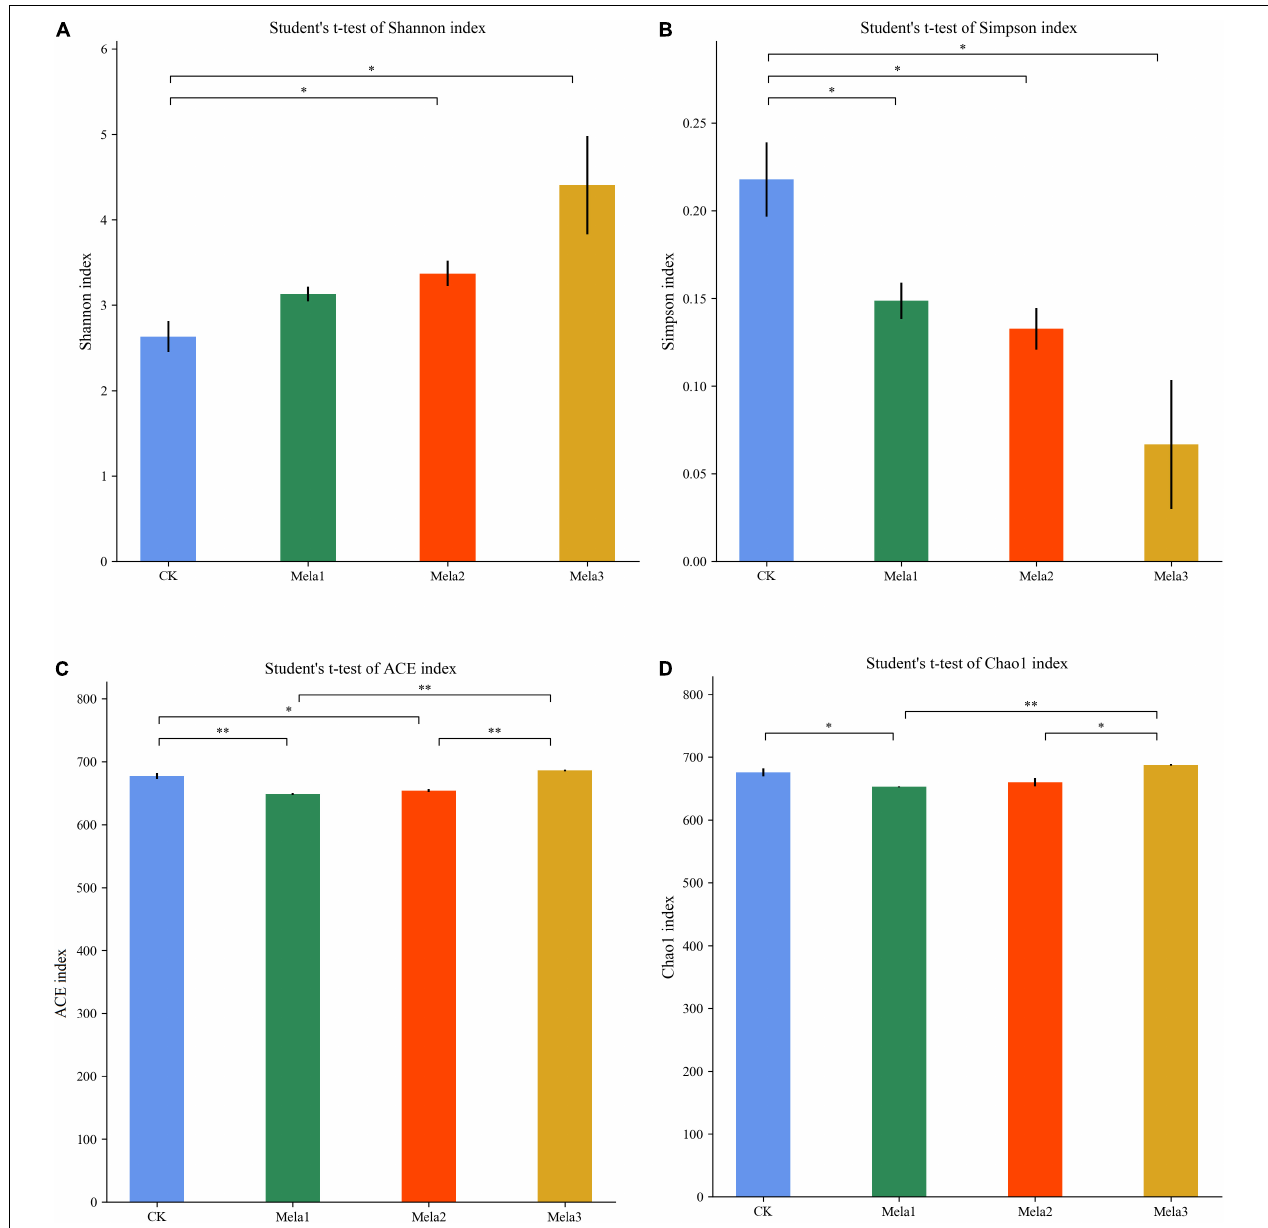
FIGURE 1 | Alpha-diversity of bacterial diversity of stylo silage supplemented with melatonin ( n =